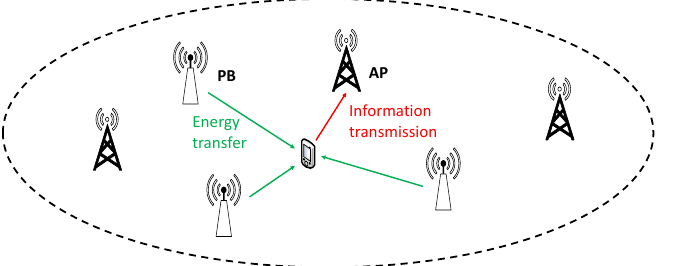
Figure 1. Energy transfer and information transmission in ultra-dense wireless powered networks